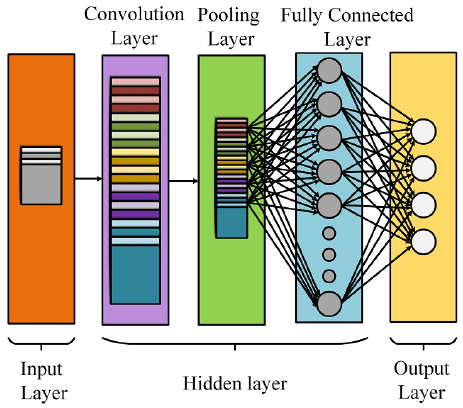
Figure 2. General CNN structure.